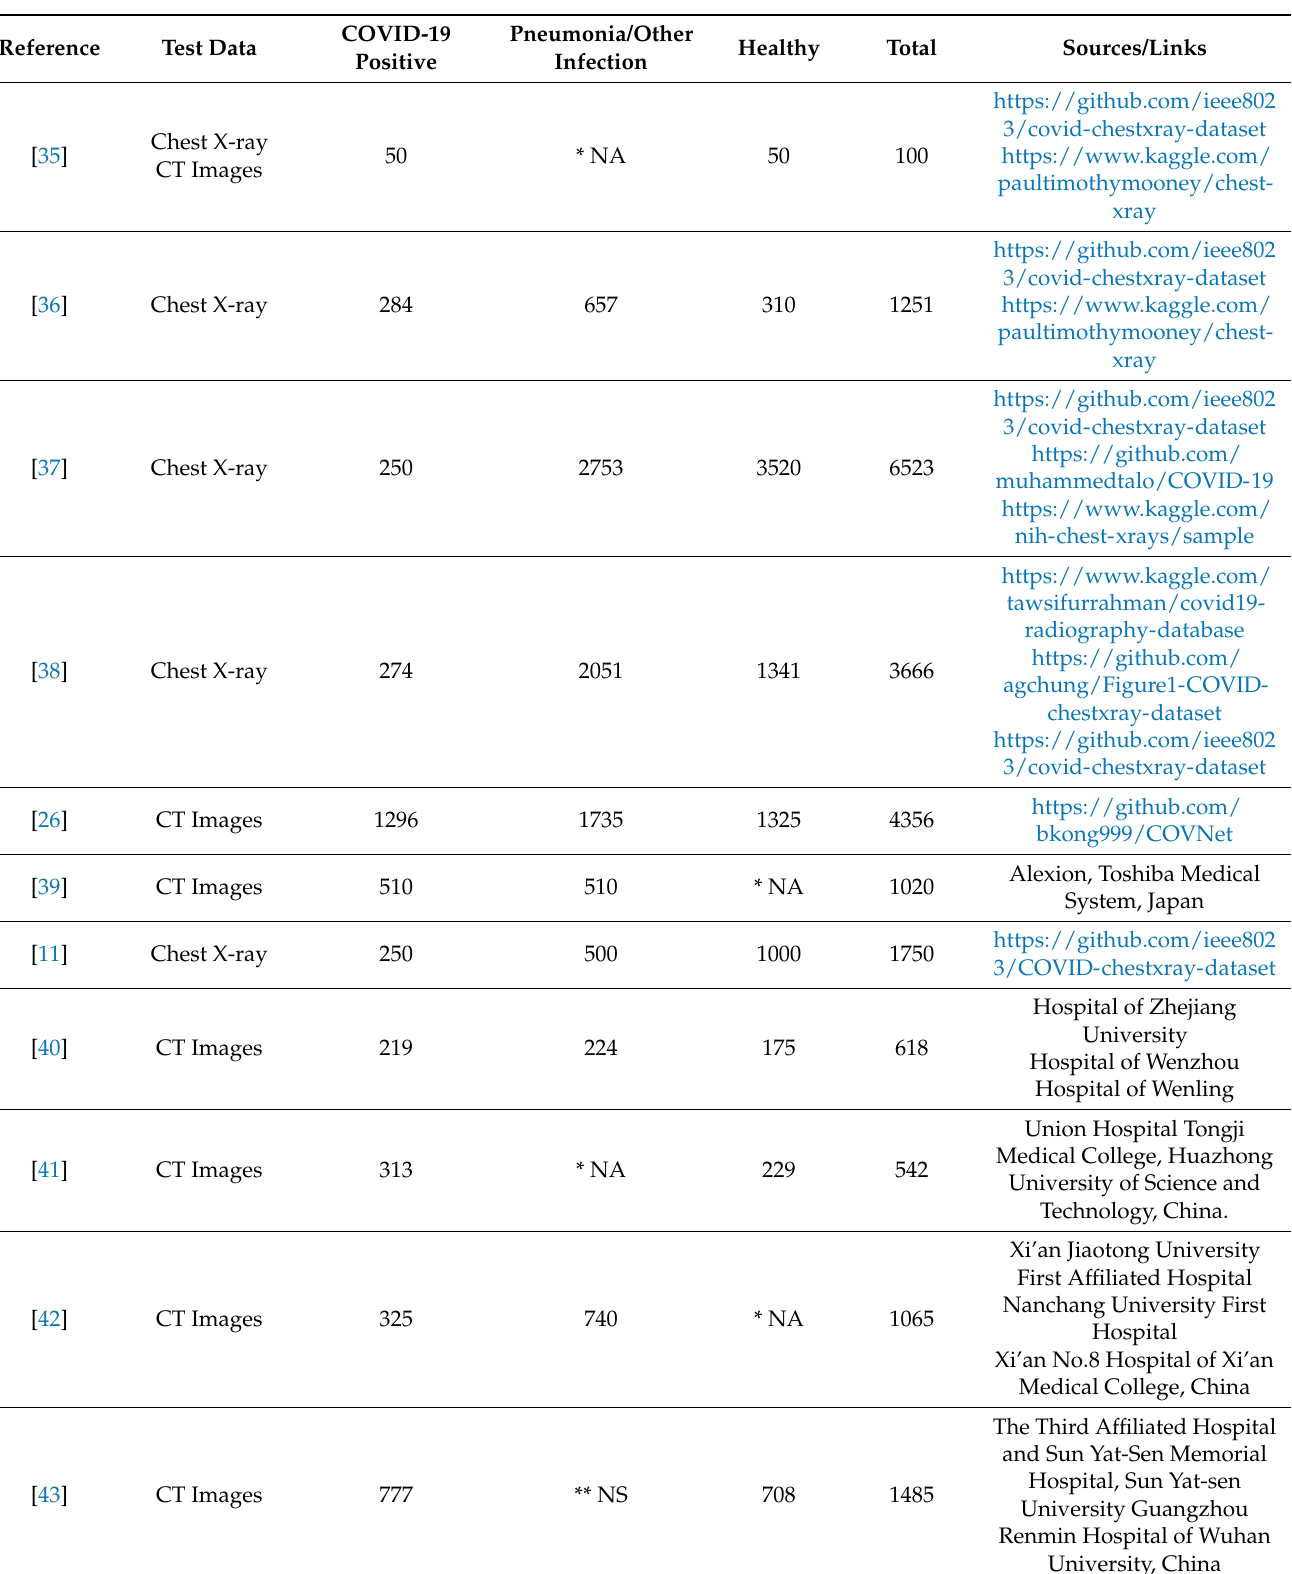
Table 1. Summary of the datasets used in the selected